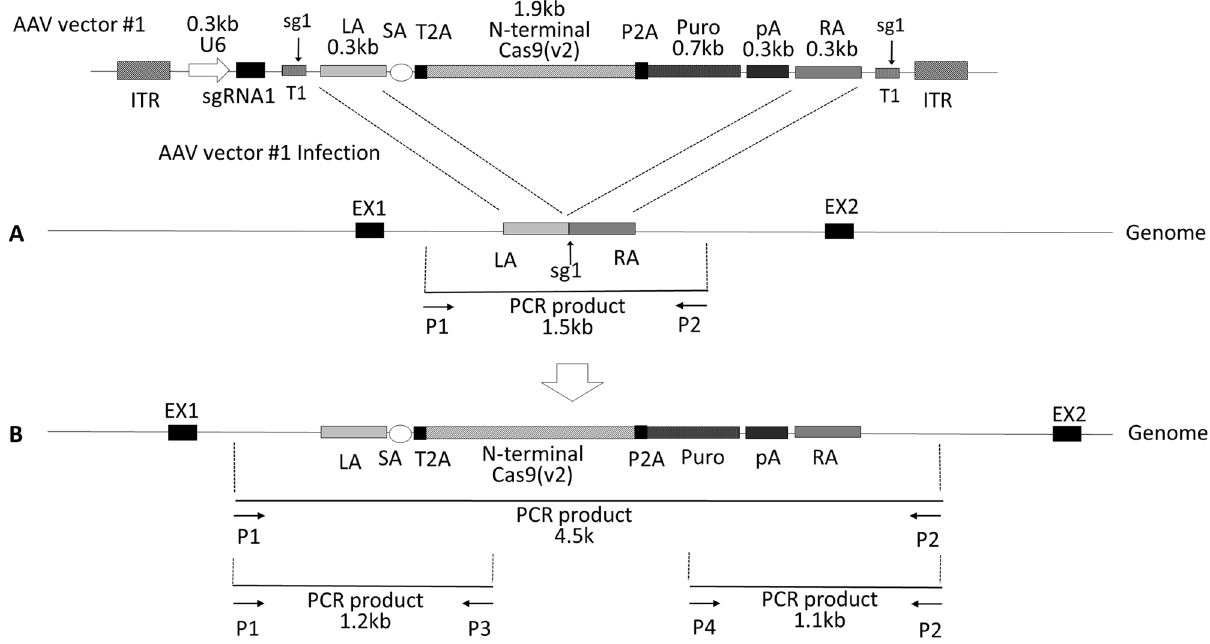
Figure 2. AAV vector #1 construct for introduction of N-terminal 1.9 kb Cas9v2 into the AAVS1 locus. ( A ) AAV vector #1 is designed to introduce the N-terminal Cas9v2 into the AAVS1 locus as a double-cut donor. The vector sequence is shown in Supplementary Table S1. T1 is the AAVS1 target site including the protospacer adjacent motif (PAM). The T1 sequence was synthesized and added adjacent to each homology arm to cut out the donor DNA from the AAV vector genome. U6, U6 RNA polymerase III promoter; sg1, AAVS1-specific sgRNA1; LA and RA, left and right homology arms; SA, splicing acceptor; T2A and P2A: Thosea asigna virus and porcine teschovirus-1 2A self-cleaving peptides; Puro, puromycin resistance gene; pA, a polyadenylation signal sequence; ITR, inverted terminal repeat. ( B ) Genome structure after integration of the donor by HDR. Primers P1–P2 for PCR were placed outside of the homology arms. Primers P1–P3 and P4–P2 were used to detect the N-terminal Cas9 and the Puro genes, respectively. The PCR primer sequences are listed in Supplementary Table